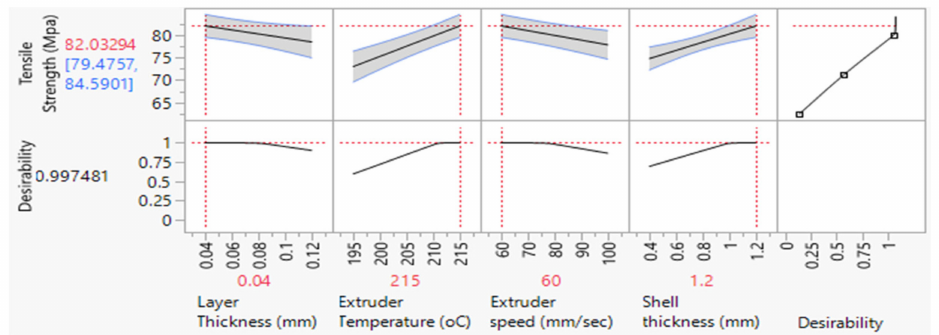
Figure 18. Desirability